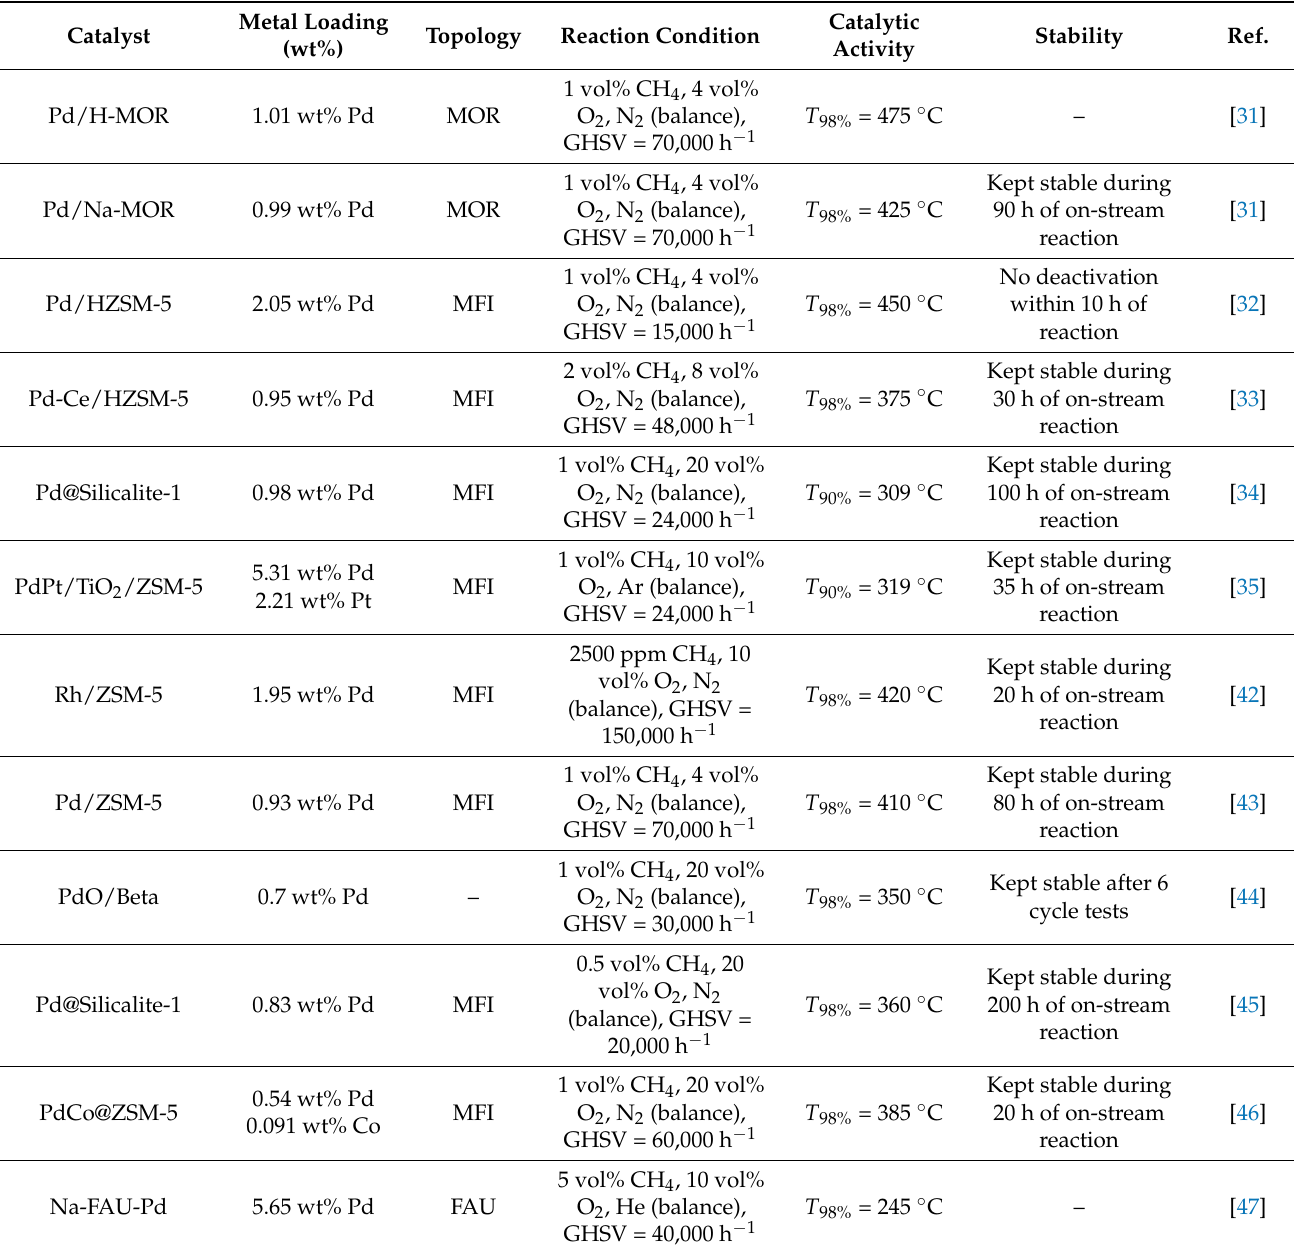
Table 1. Summary of operation conditions and catalytic activities of the typical zeolite-based catalysts for the combustion of